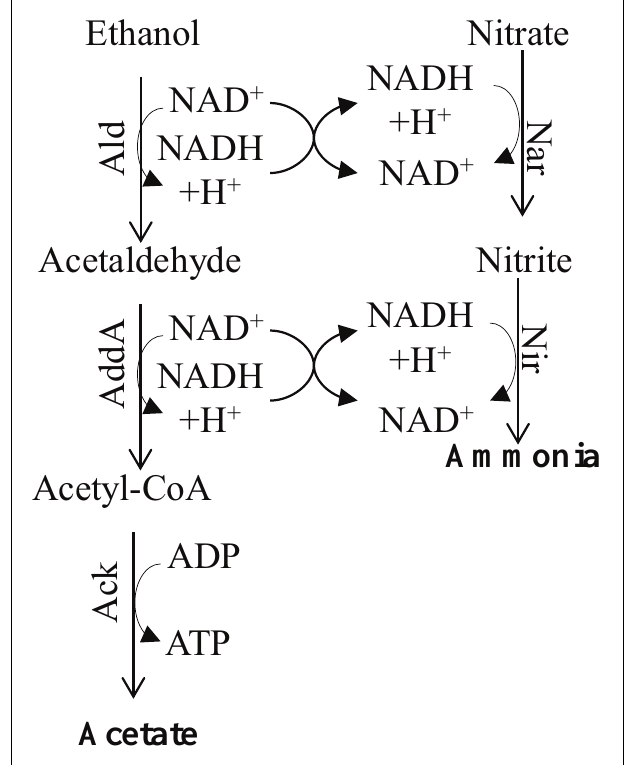
FIGURE 7 | Metabolic pathway for ammonia fermentation coupled to acetogenic oxidation of ethanol and substrate-level phosphorylation. The protein designations in this figure are: Ald, alcohol dehydrogenase; Adda, acetaldehyde dehydrogenase; Nar, nitrate reductase; and Nir, nitrite